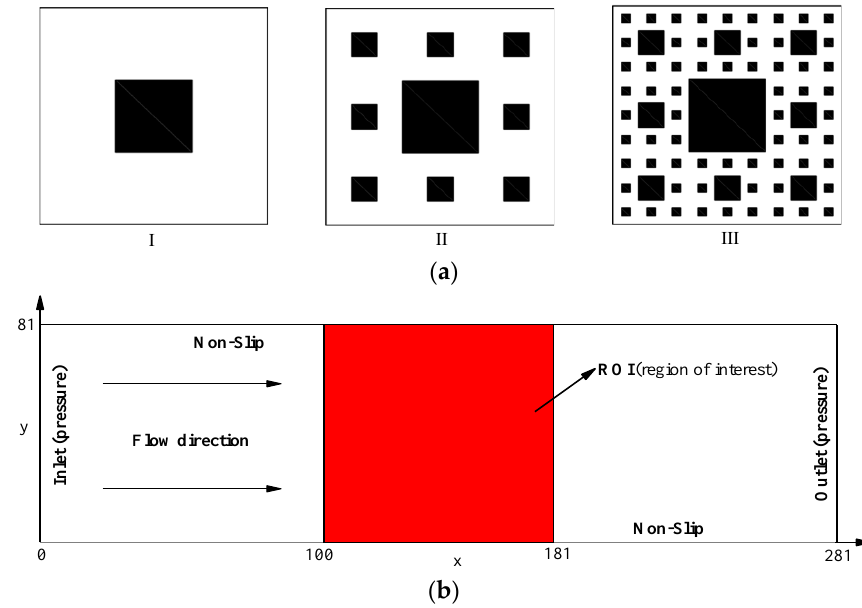
Figure 1. ( a ) The structure of ROI (white pore and black obstacles). ( b ) The diagram of flow model. The physical properties and boundary conditions of flow model are listed in Table 1.